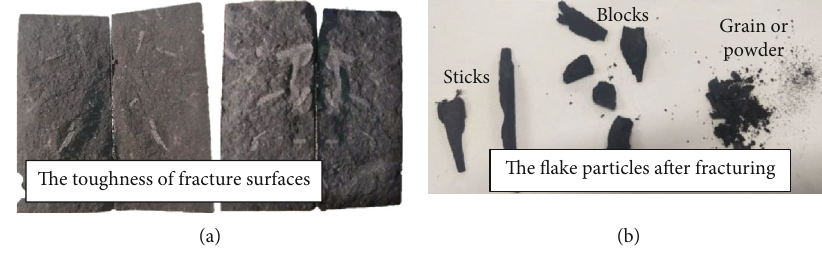
Figure 11: Fracture surfaces and fl aking